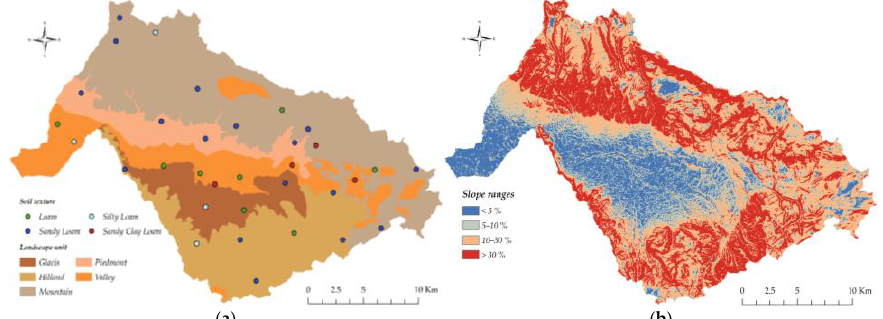
Figure 6. Distribution of ( a ) soil texture types and ( b ) slope classes in the landscape units in Rocha River catchment.